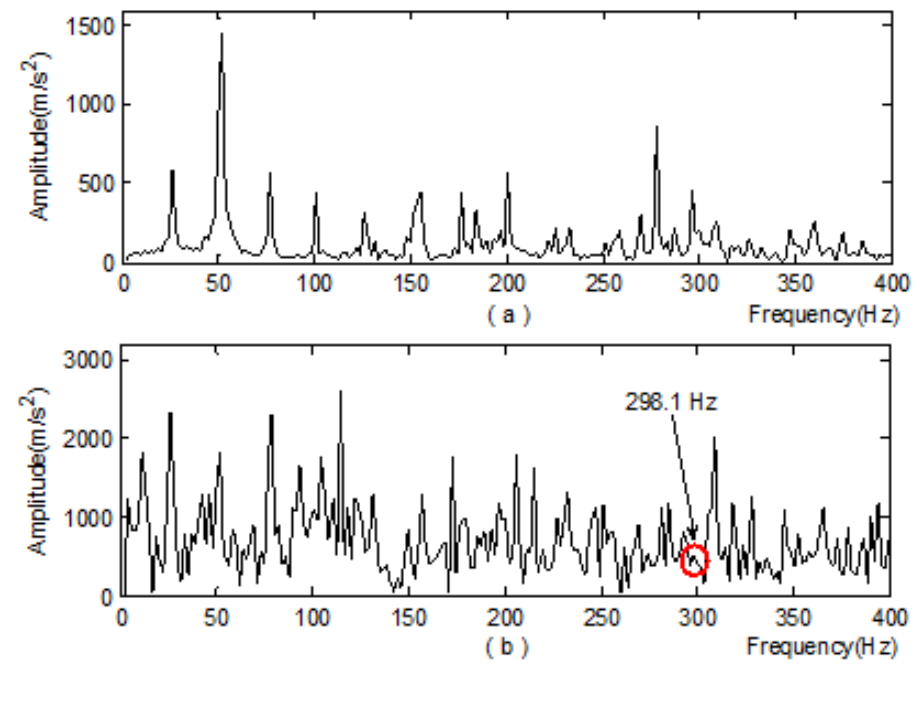
Figure 6. Comparative analysis on feature extraction of vibration acceleration signal in the case of rolling element failure: ( a ) Local spectrum; ( b ) Demon spectra; ( c ) Demon spectra of the signal obtained from adaptive redundant lifting and single branch reconstruction of the